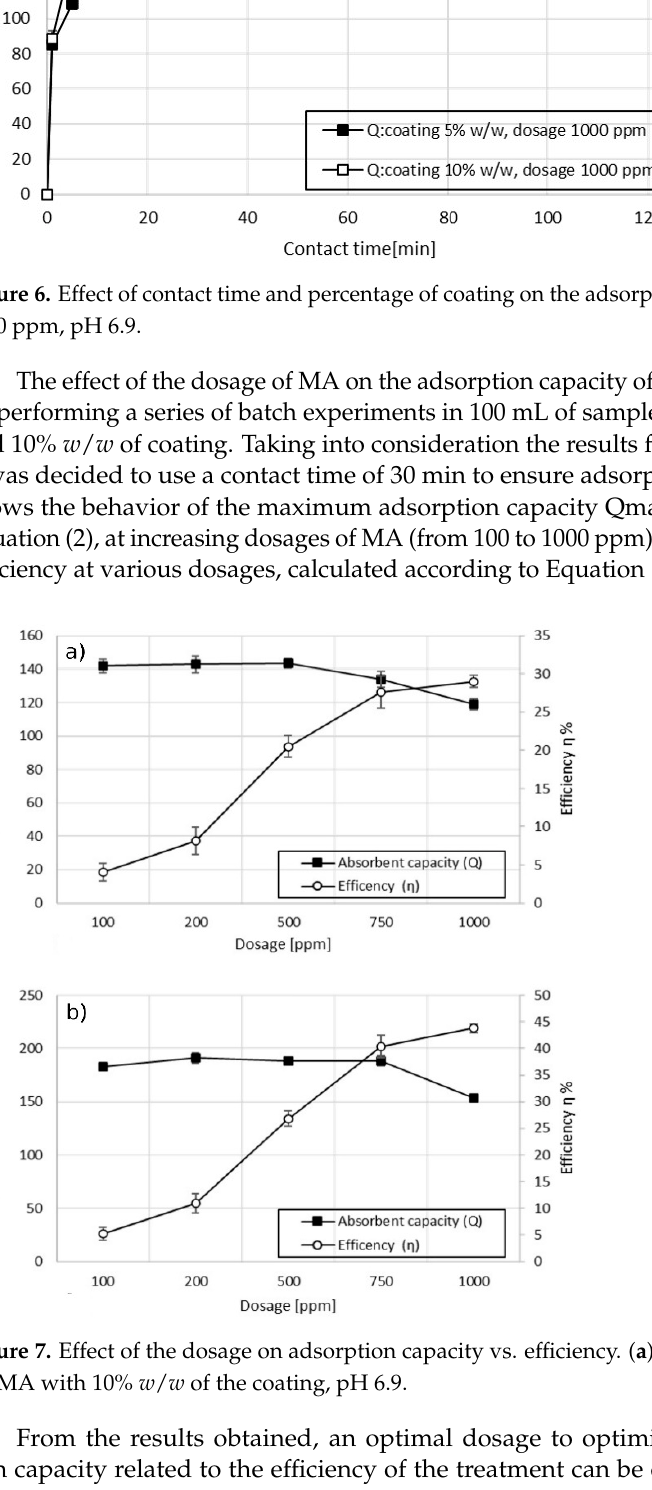
8 of 20 Figure 5. VSM curve of functionalized MA at room temperature. ( a ) Magnetic saturation, ( b ) coercivity behavior. 3.2. Adsorption Tests Experiments were carried out to establish the contact time needed to reach the ad- sorption equilibrium. This condition is found when the MA reach their maximum adsorp- tion capacity and efficiency and indicates the contact time needed for performing an effi- cient treatment. This information is crucial for the correct design of the treatment equip- ment. Short contact time for reaching the equilibrium means a small size reactor and space needed, thus lower costs. The experiments were carried out in batch mode in 100 mL of each of the wastewater samples (sample 1 and sample 2). MA with different percentages of coating (5–10% w/w ) and a dosage of 1000 ppm were used for the experiments that had a duration of 120 min. Samples of treated water were taken for the ICP-MS analysis at different time points. The efficiency was measured as reported in Equation (1). 3.2.1. Single-Ion Adsorption Results obtained from sample 1 measurements (containing only copper ions) show